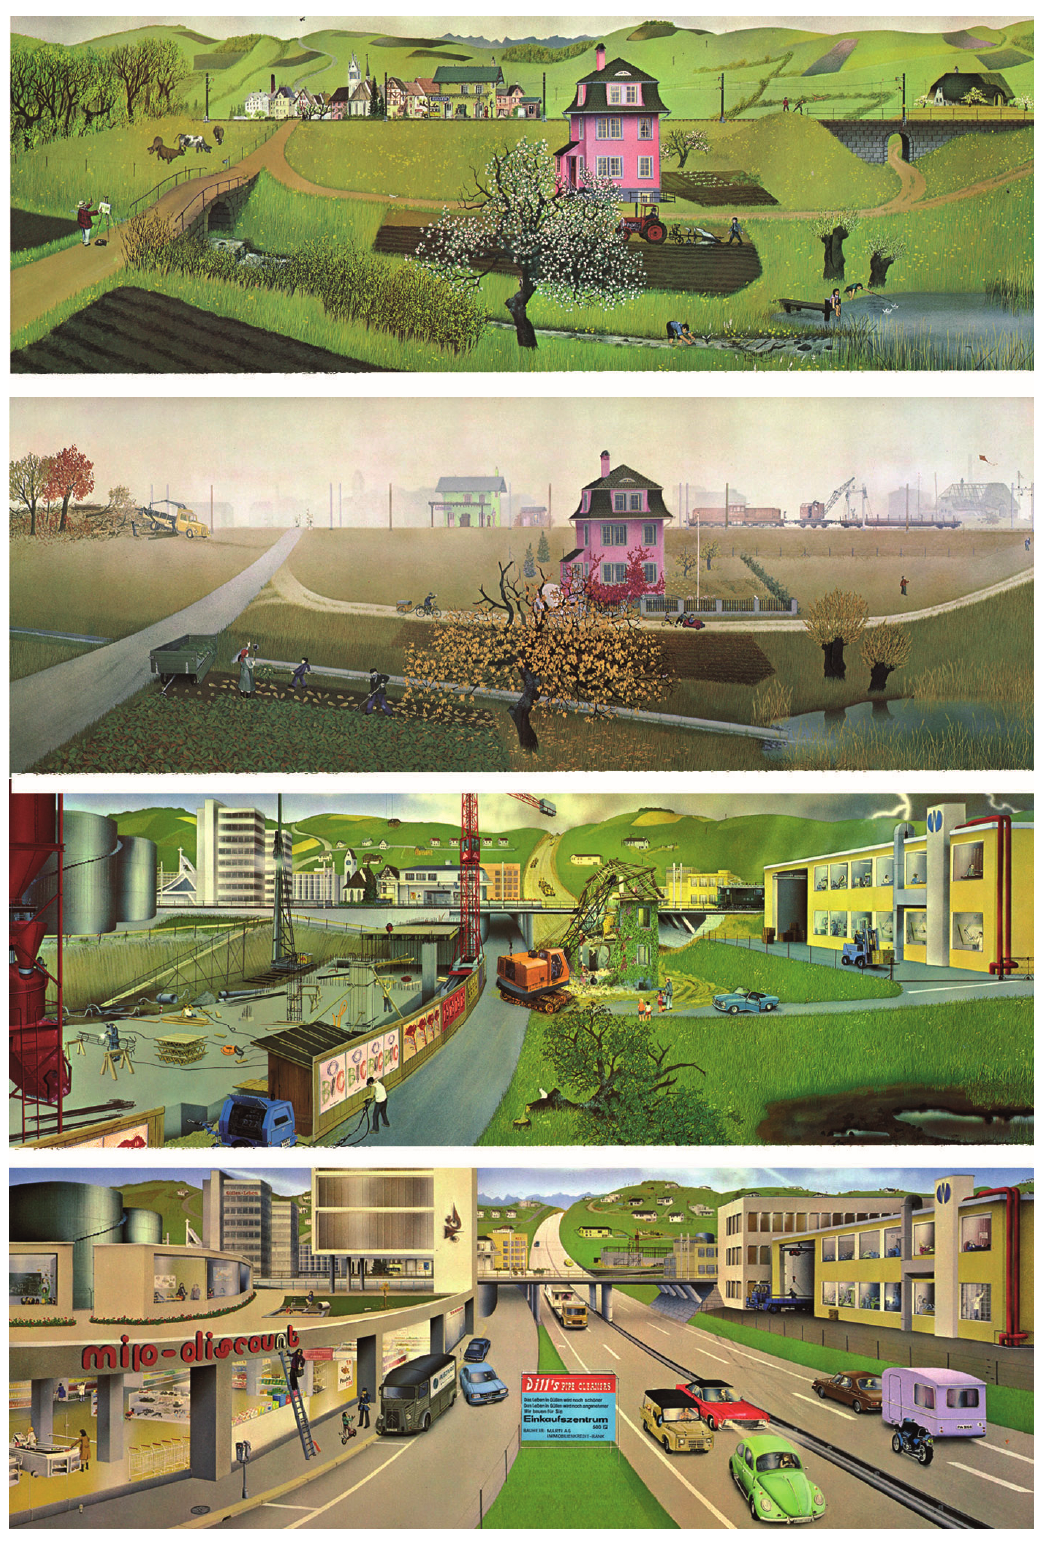
Figure 1. The changing countryside (© by Jörg